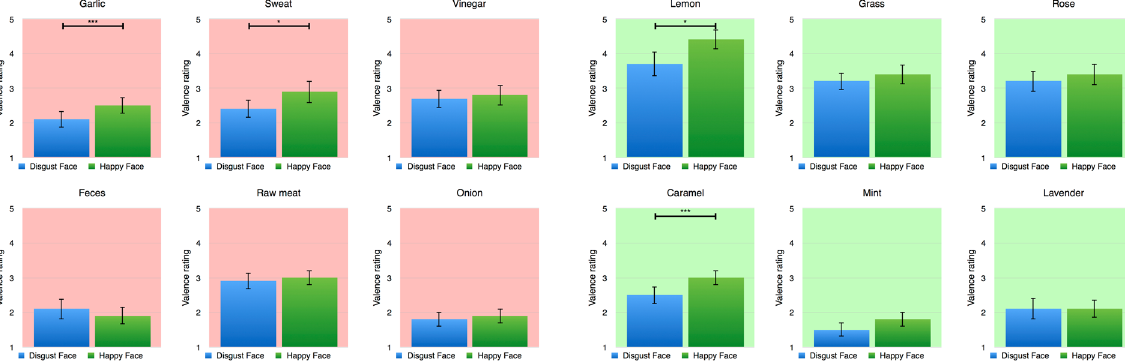
Figure 2. Priming effects on valence perception driven by single odors. All odors but the smell of feces at least show a tendency of an increased pleasantness following a happy face compared to disgust faces. * Signifies a statistically significant difference at the threshold 0.05 and *** signifies a statistically significant difference at the threshold